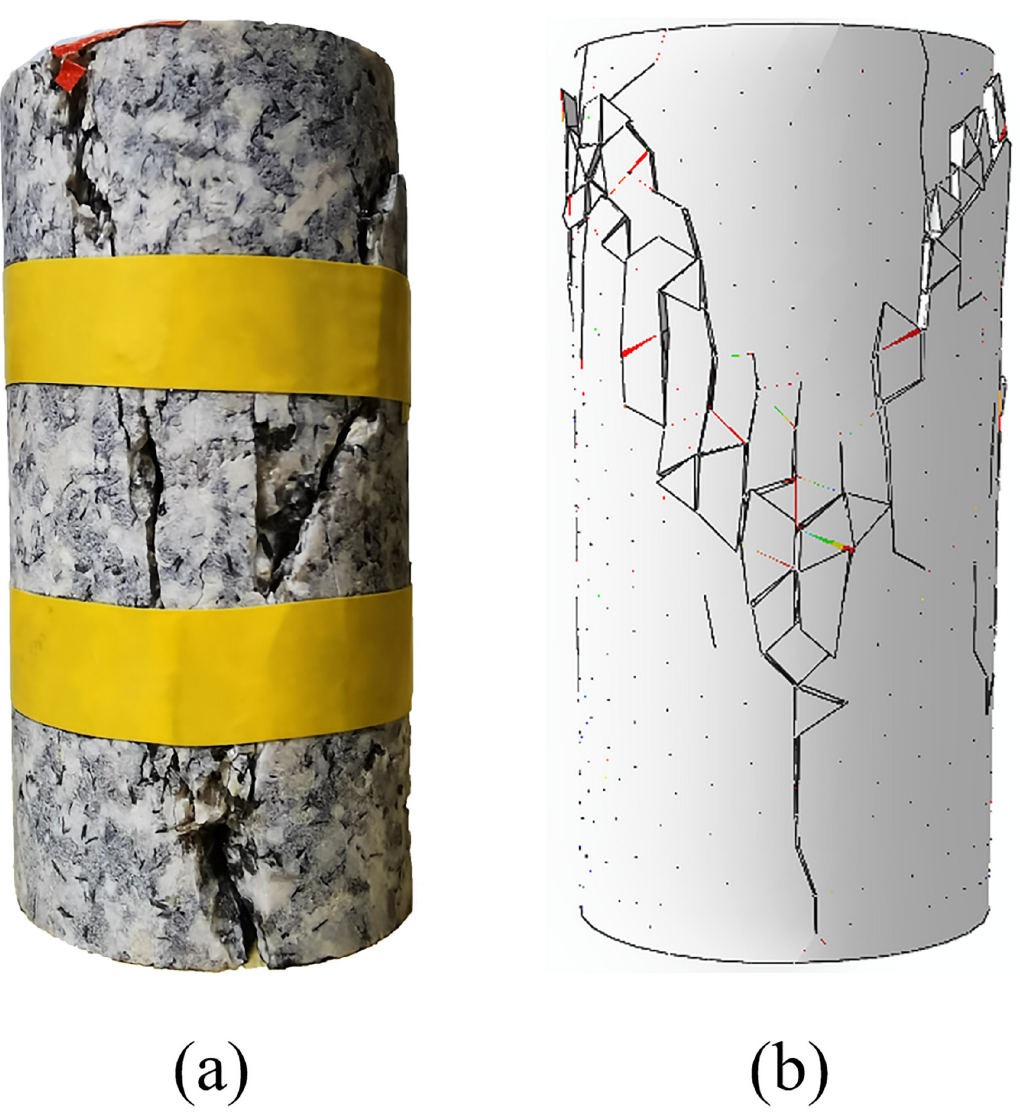
Fig 7. Uniaxial compressive test. (a) the failure mode of granite sample obtained from laboratory test; (b) the failure mode predicted by the numerical model.